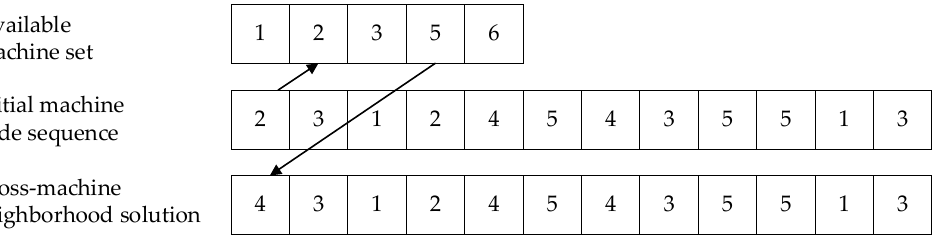
Figure 6. Schematic diagram of cross-machine neighborhood search for bottleneck process.